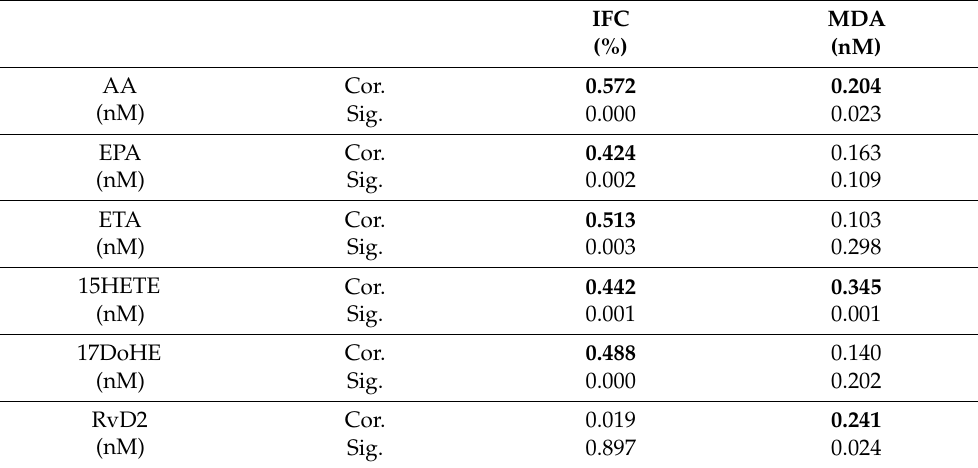
Table 3. Correlation between the circulating levels of free fatty acids and oxylipins and the intrahep- atic fat content or malondialdehyde